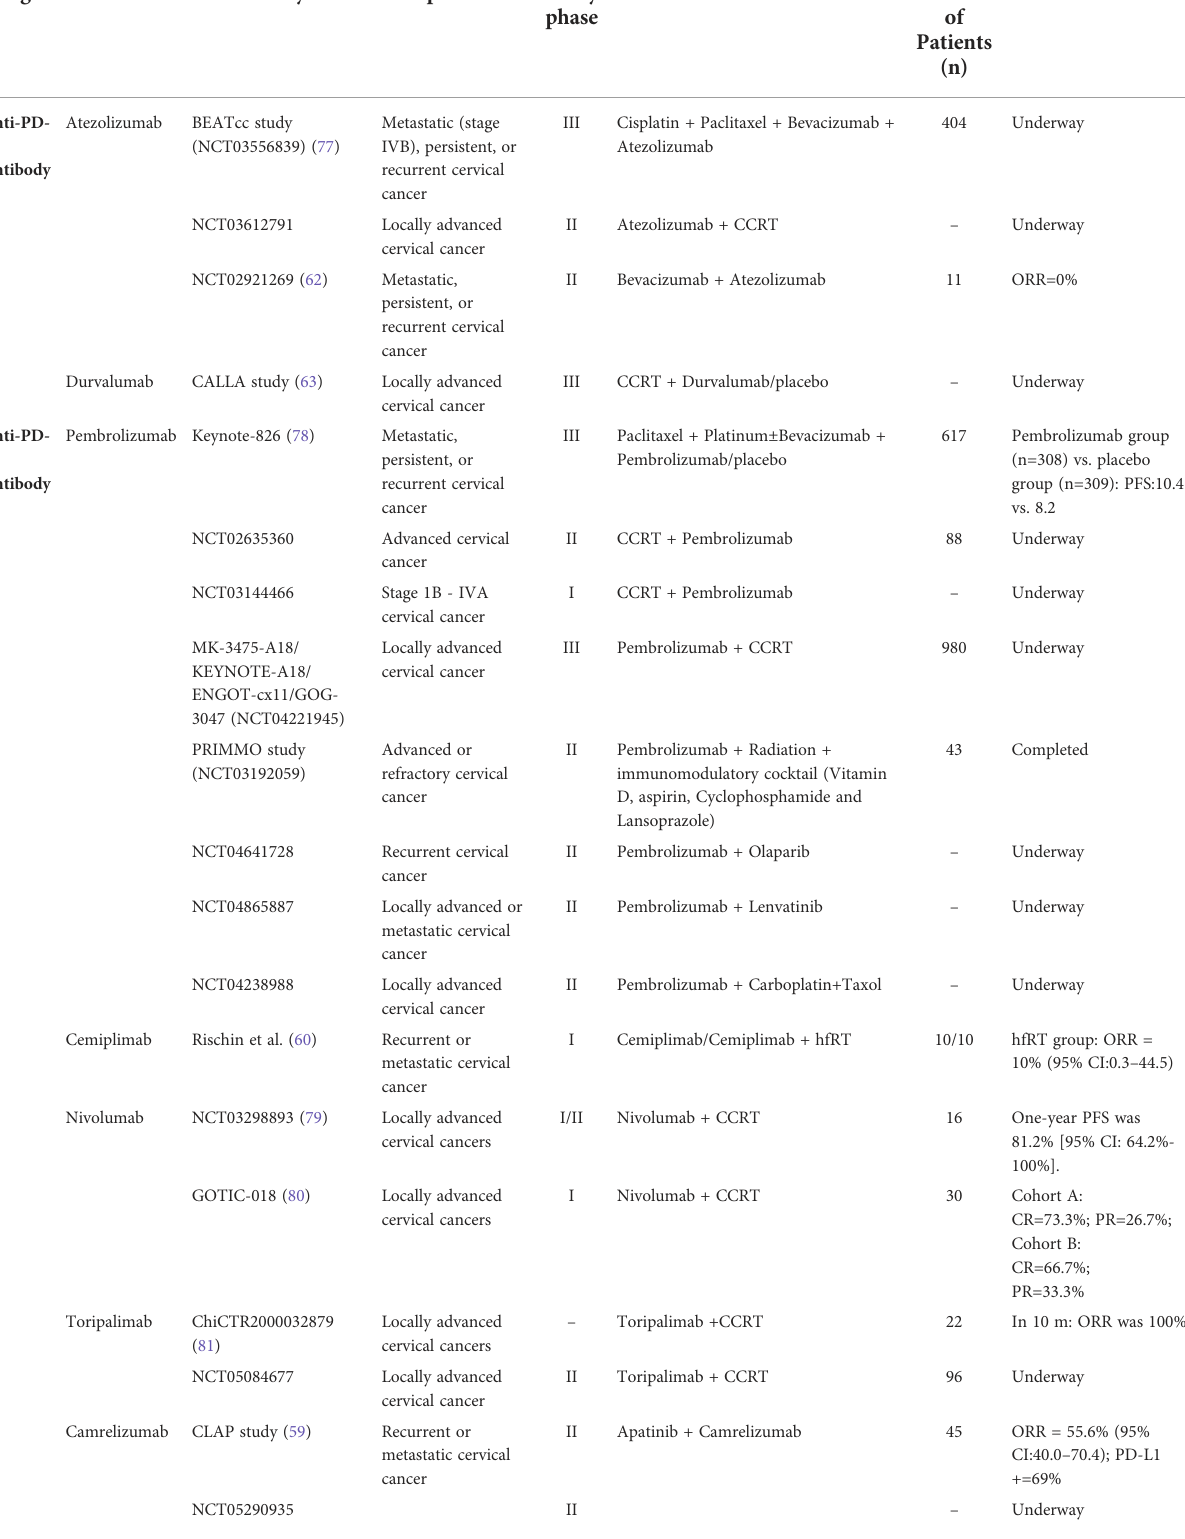
TABLE 3 Trials combining the use of ICIs with radiotherapy, chemotherapy, antiangiogenic therapy, and targeted